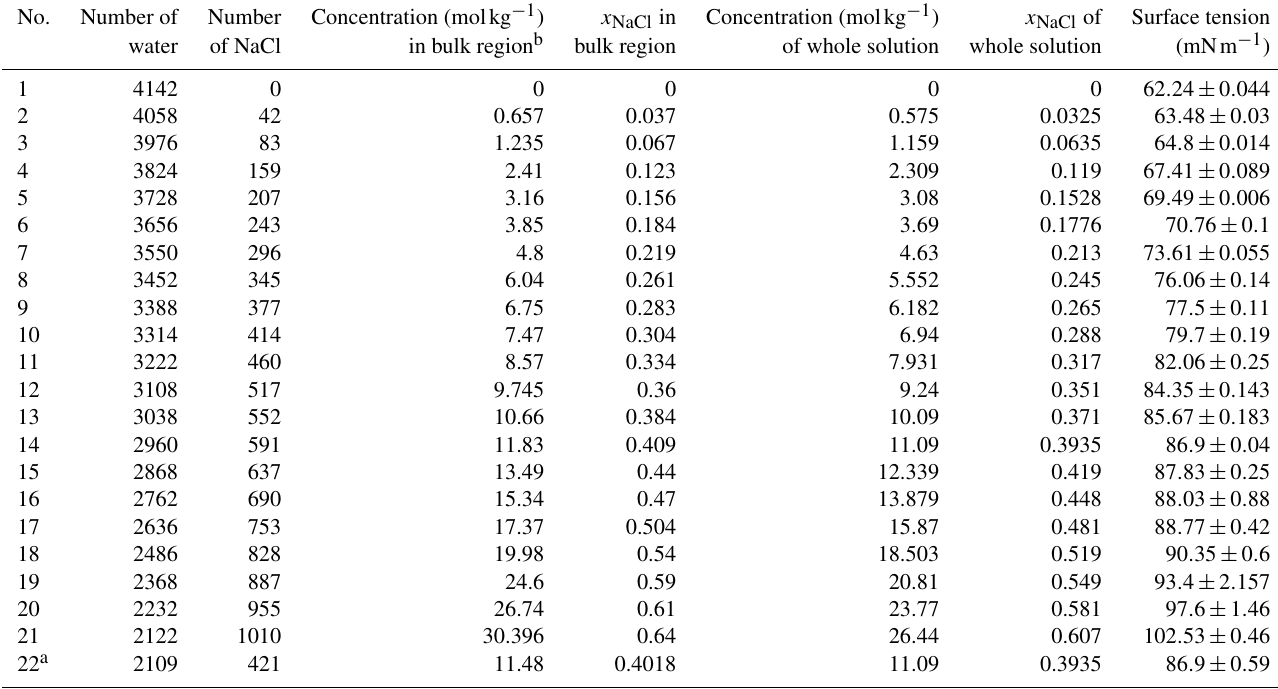
Table 1. Concentrations of solution studied in our simulation and the calculated values of surface tension.